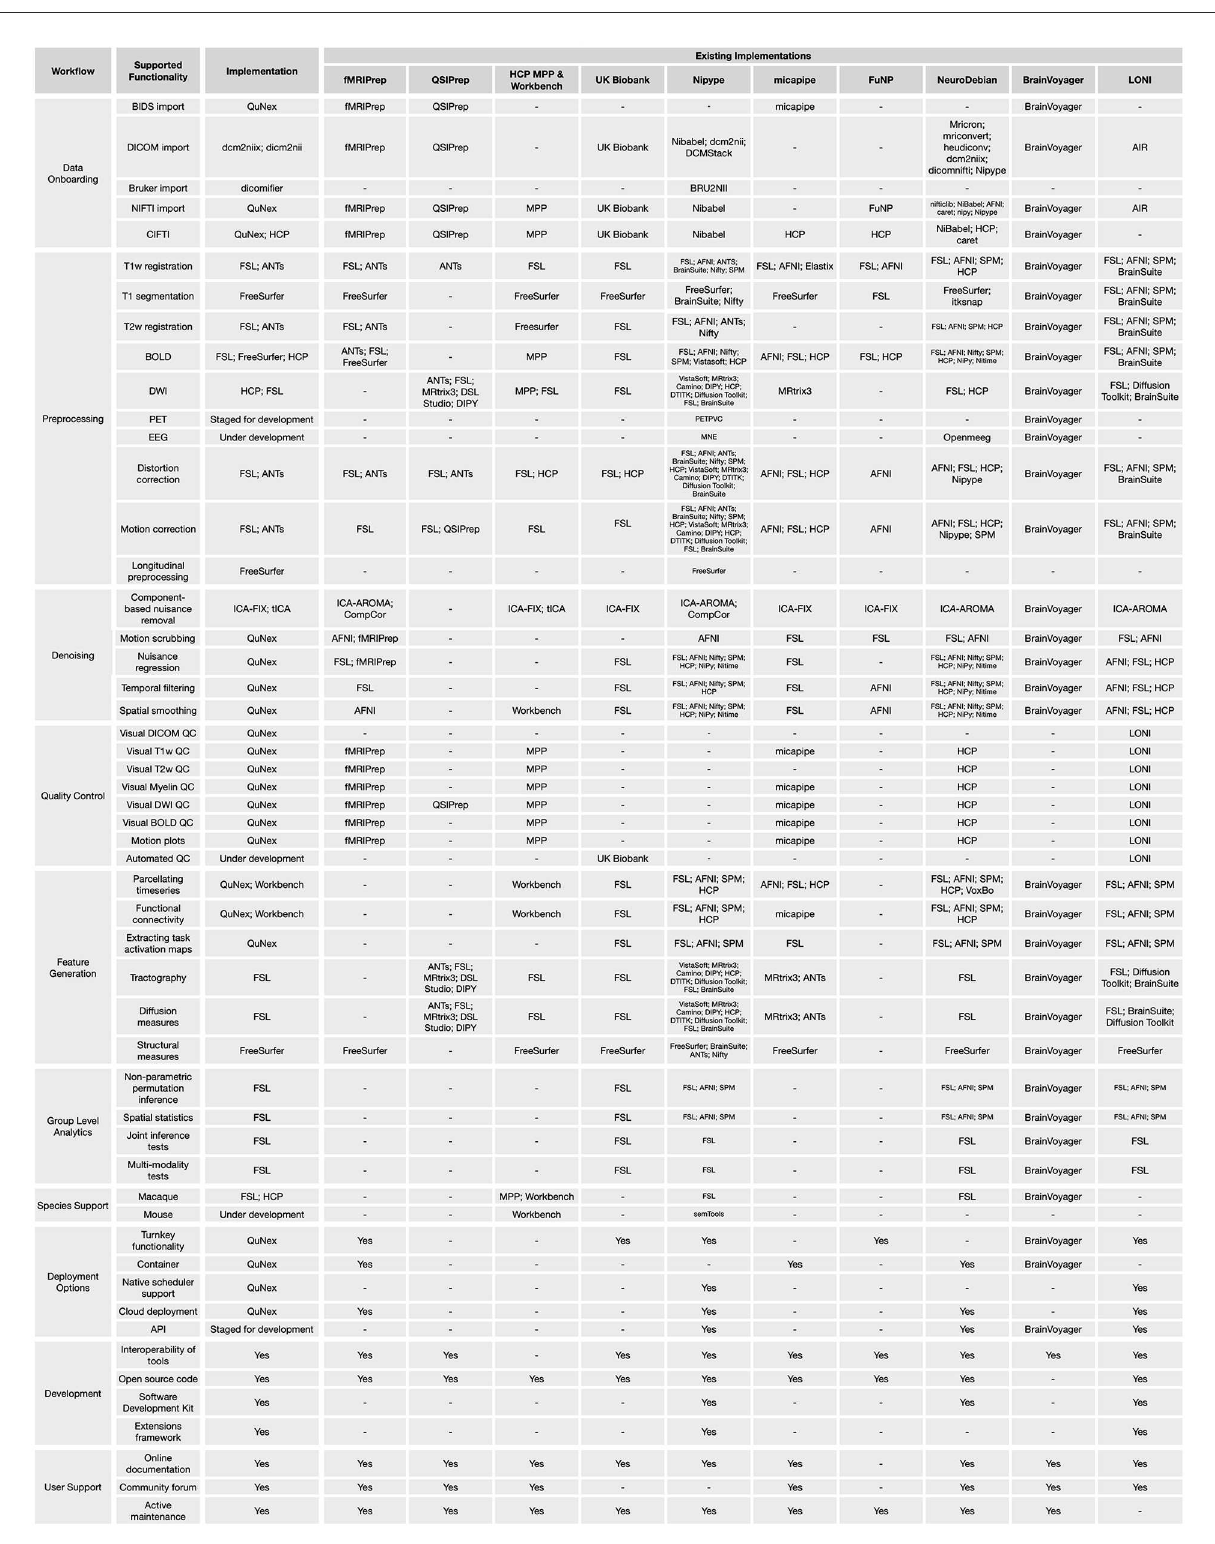
FIGURE7 Features included in QuNex and comparisons to other neuroimaging software. A list of tools integrated into QuNex along with supported QuNex functionalities. We also list functionalities and tools currently available in some popular neuroimaging pipelines/environments, including fMRIPrep (Esteban et al., 2019), QSIPrep (Cieslak et al., 2021), HCP (Glasser et al., 2013), UK Biobank (Alfaro-Almagro et al., 2018), nipype (Gorgolewski et al., 2016), micapipe (Cruces et al., 2022), FuNP (Park et al., 2019), NeuroDebian (Halchenko and Hanke, 2012), BrainVoyager (Goebel, 2012), and LONI (Dinov et al.,